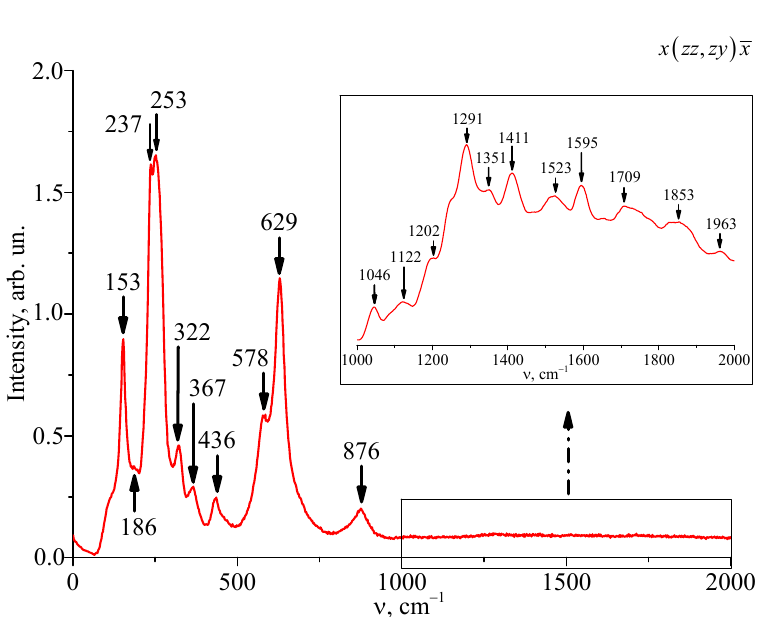
Figure 2. Raman spectra in the band of 50–2000 cm –1 for the backscattering geometry of a LiNbO 3 :Gd 3+ (0.003):Mg 2+ (0.65 wt.%) crystal obtained upon excitation by a laser line with a wave ‐ length of 532 nm.